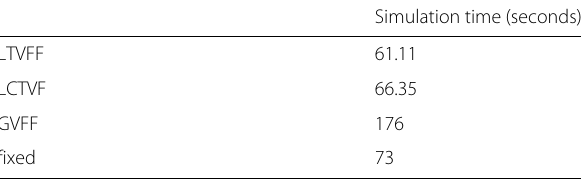
Table 6 Simulation time of running different algorithms in Figs. 15 and 16